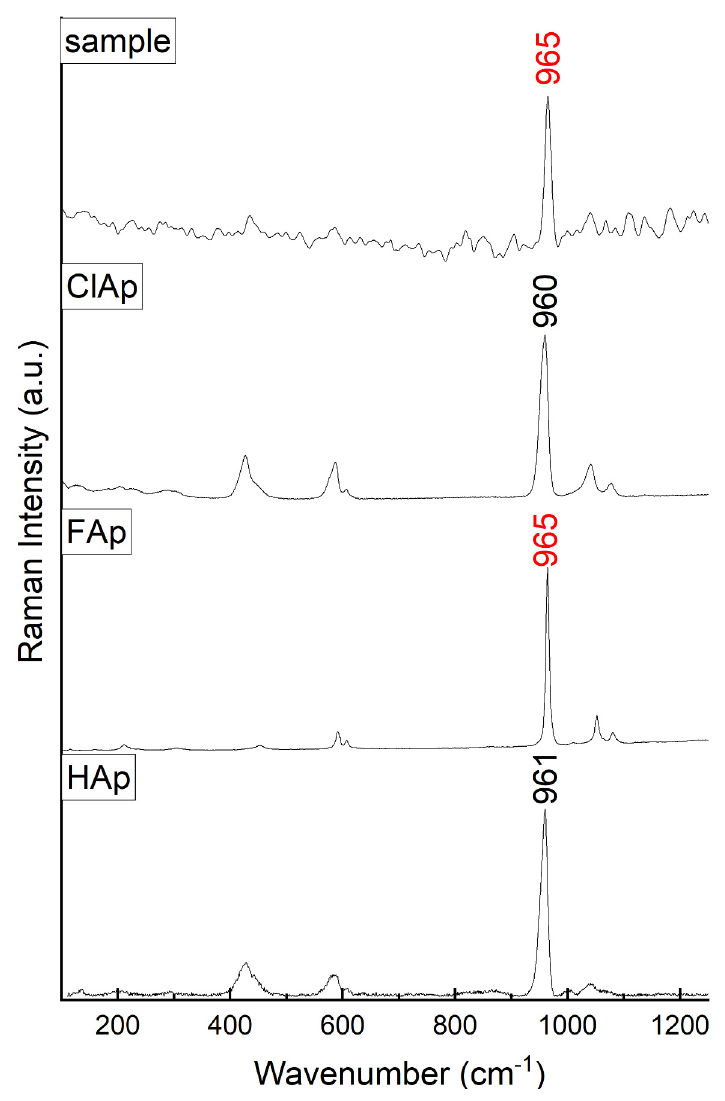
Figure 9. Raman spectra of the apatite spectrum collected from the meteorite and the reference spectra of chlorapatite (ClAp, RRUFF ID R060192), fluorapatite (FAp, RRUFF ID R040098), and hydroxyapatite (Hap, RRUFF ID R060180). The standard spectra of apatites are from the RRUFF Raman spectra database [61].